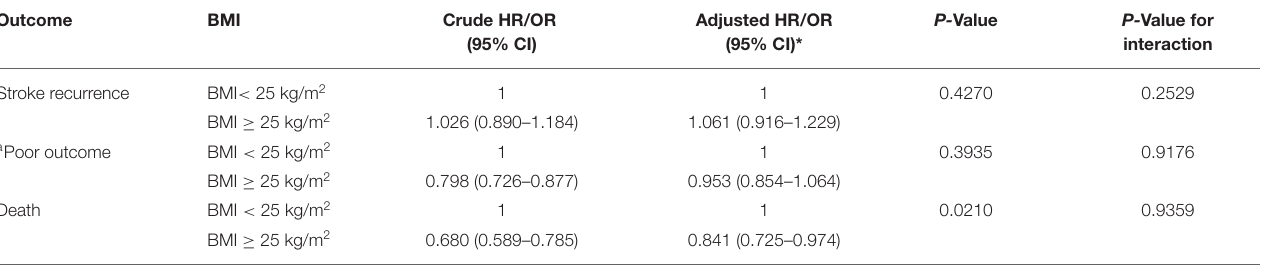
P- Value P- Value for Adjusted HR/OR (95% CI) (95% CI)* interaction